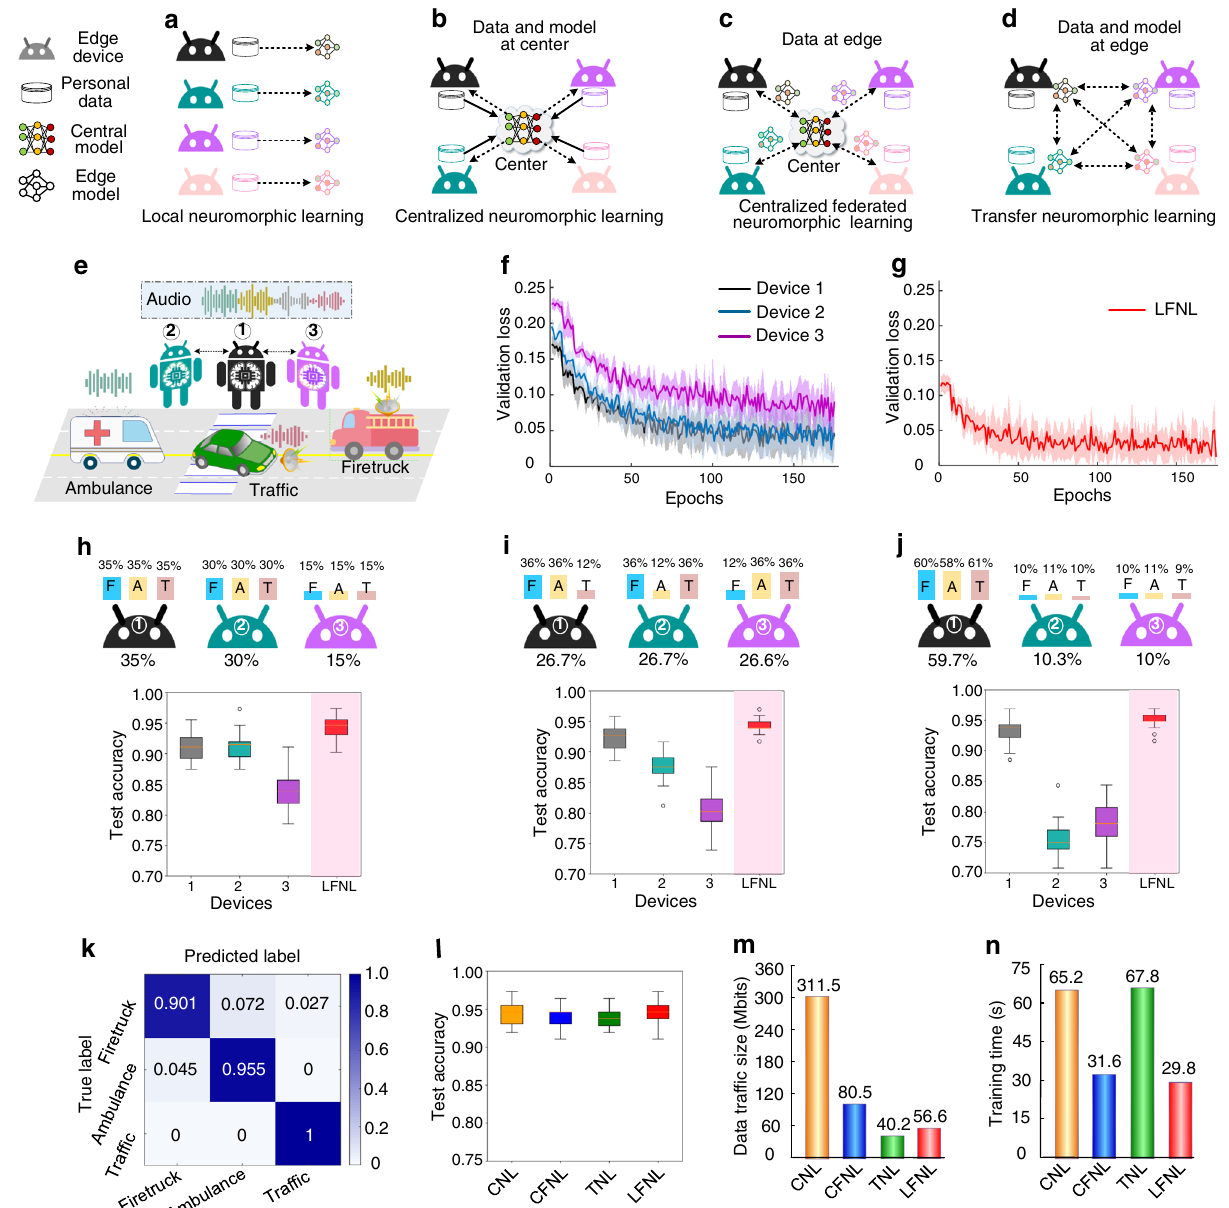
Fig. 2 | LFNL for audio recognition on a road. a Principle of local neuromorphic learning (LNL) with data and model on the devices. b Principle of centralized neuromorphic learning (CNL) with data and model being stored at the central server. c Principle of centralized federated neuromorphic learning (CFNL) with data being kept on the devices, and localmodelparameters being uploadedto the central server for model aggregation. d Principle of transfer neuromorphic learning (TNL) with data being kept on the device side, and each device trains its model and then passes it to the next device for training, cyclically repeating the process. e An example of audio recognition on a road, including fi retruck,